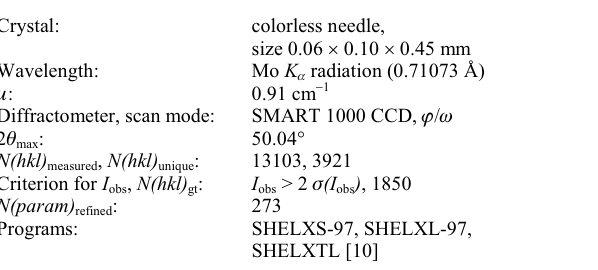
Table 1. Data collection and handling.